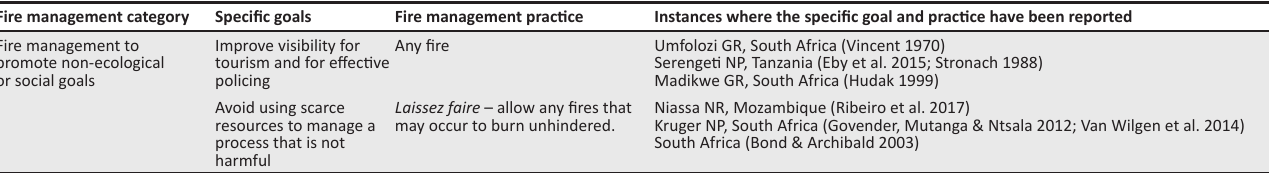
TABLE 1 (Continues ...): Fire management goals and associated practices that have been proposed, or are used, for the management of fire in African savanna-protected